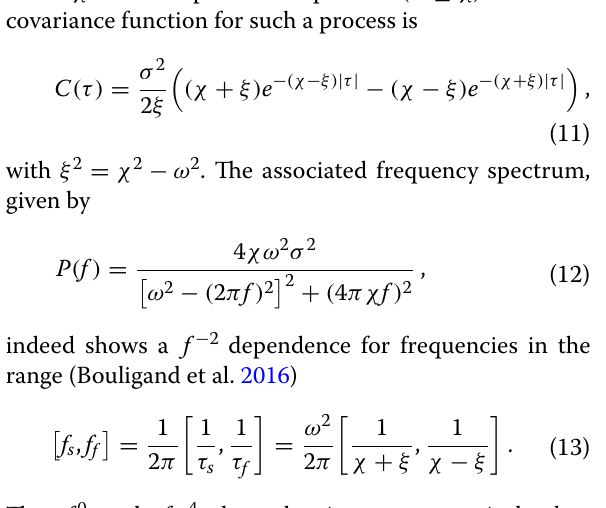
Our choice for the values of the three parameters that enter Eq. (11) slightly departs from that made by Hellio and Gillet (2018) for the construction of the archeomag- netic field models COV-ARCH and COV-LAKE (see 0 = − 24, 000 nT and Table 1). The background value ¯ g 1 = 7700 nT are estimated from the average the r.m.s. σ g 0 1 and standard deviation of the axial dipole moment over the past 2 Myr, as estimated with the SINT2000 model (Valet et al. 2005). As described in Additional file 1, alternative estimates are possible (see also Buffett et al. 2013), and our choice of parameters for the axial dipole, relatively conservative, is a compromise between